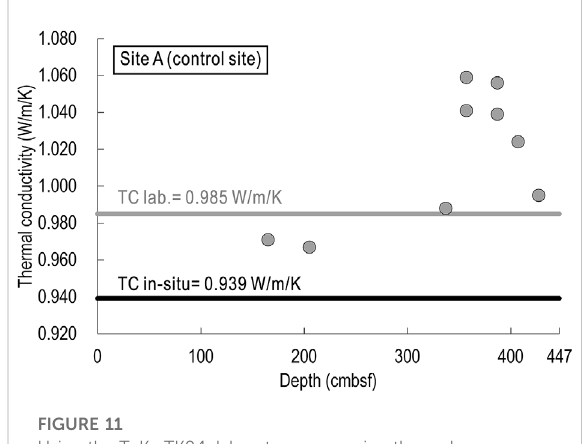
FIGURE 11 Using the TeKa TK04, laboratory-measuring thermal conductivity (dots) for sedimentary core retrieved in Site A is shown. The representative value (gray line) for the whole core and its correction to in situ condition (black line; Hyndman et al., 1974) are also displayed.